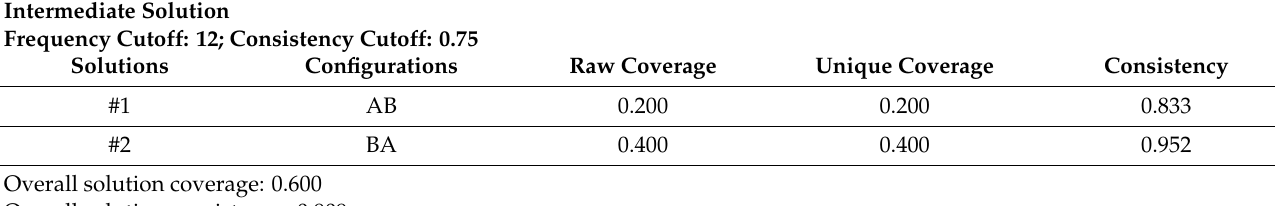
Table 10. Intermediate solution to correct recognition of Hazard